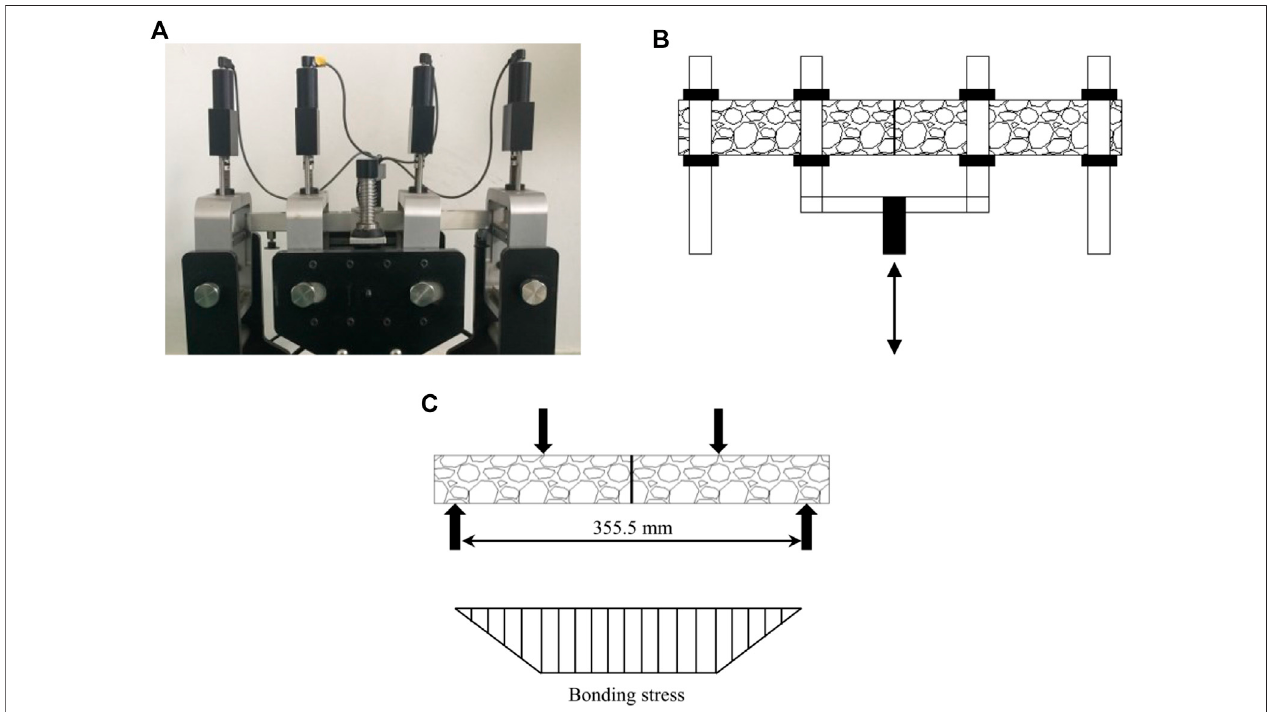
FIGURE 4 | Four-point bending test equipment and loading diagram: (A) four-point bending test setup; (B) fatigue loading mechanism; (C) schematic diagram of